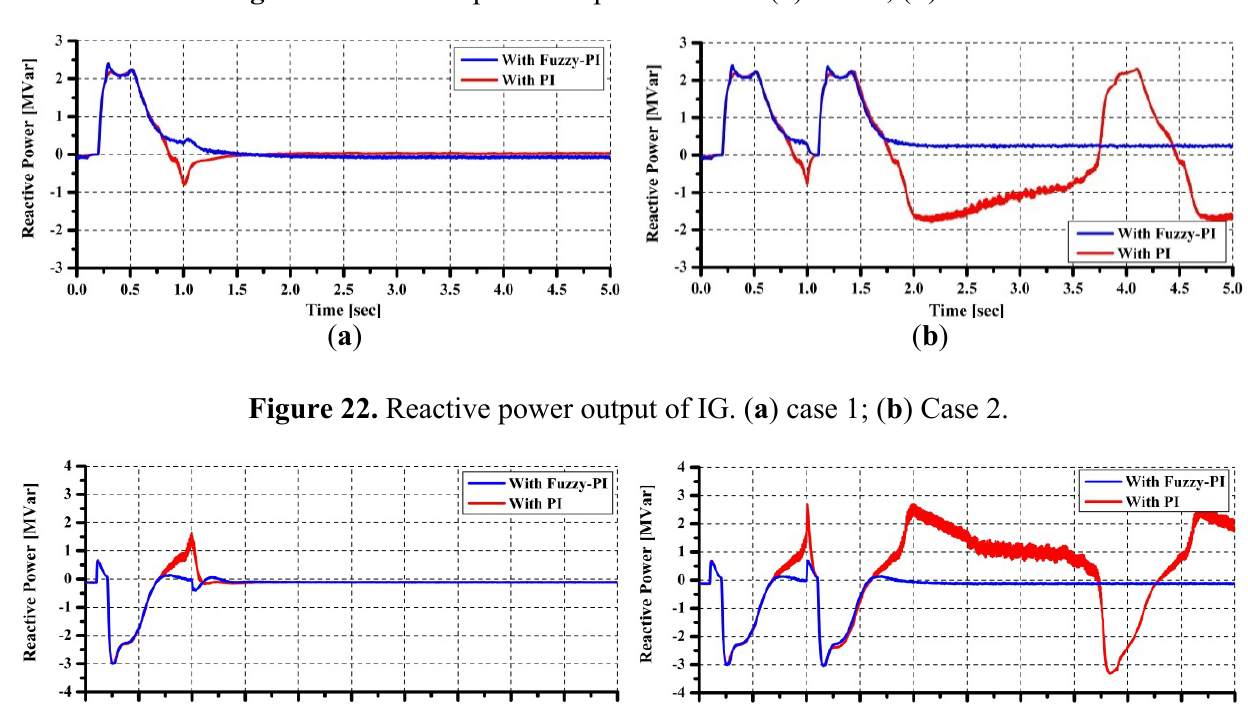
Figure 21. Reactive power output of PMSG. ( a ) case 1; ( b ) Case 2.